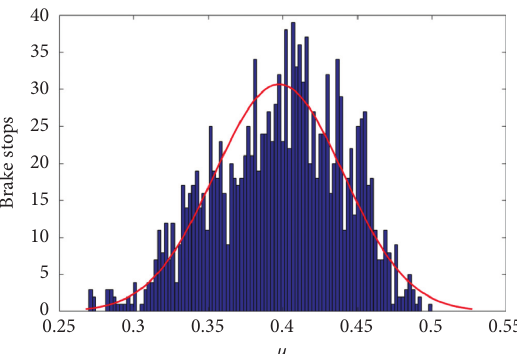
Figure 10: Probability distribution of the friction coefficient from the SAE J2521 test.